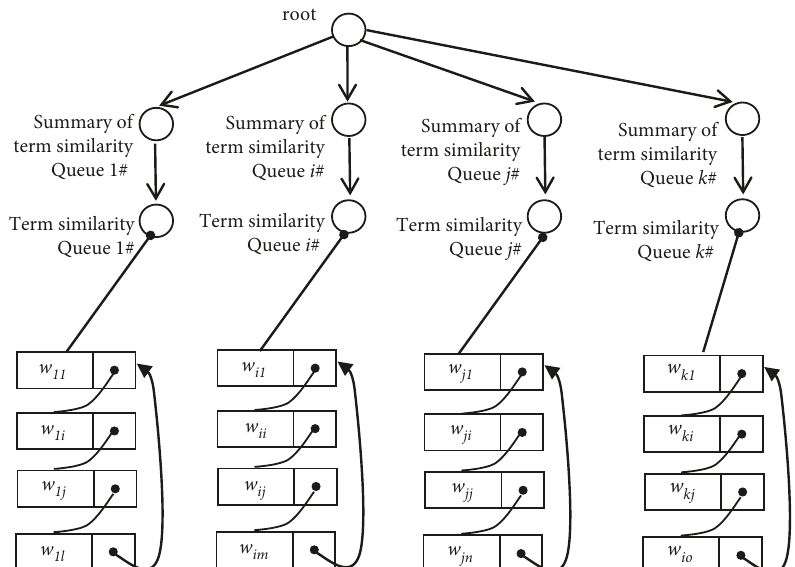
Figure 3: Term similarity weighing tree. Term similarity weighting tree (TSWT) can be constructed automatically according to flowing